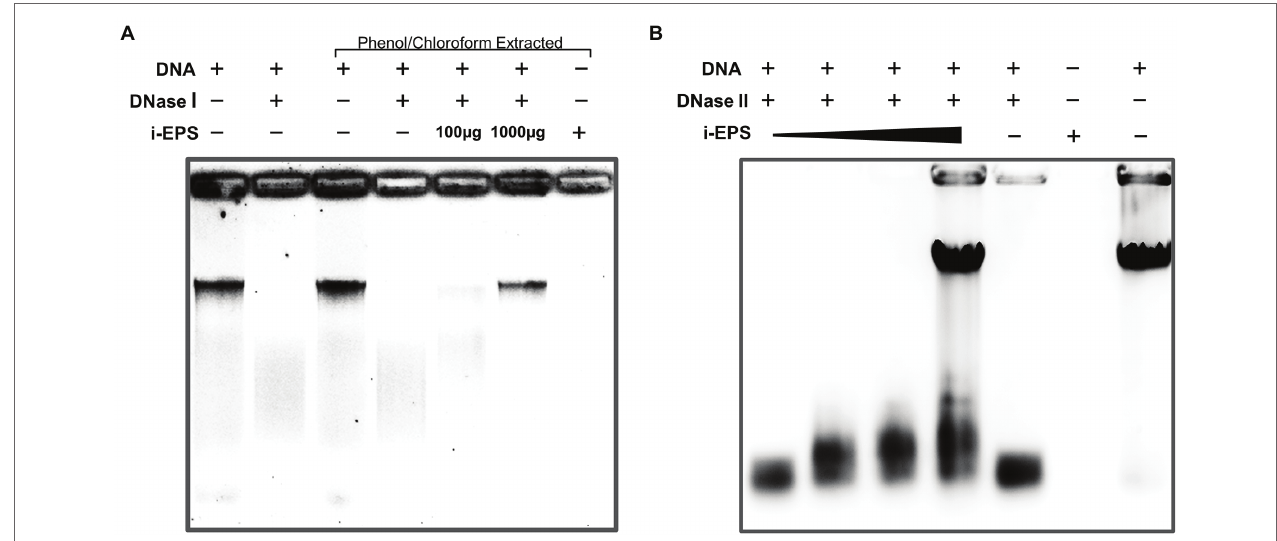
FIGURE 7 | Electrophoretic profile of digested DNA by DNase I (A) and DNase II (B) in the presence (+) and absence ( − ) of i-EPS. The DNA was electrophoresed on a 1.0% agarose gel. The gels were stained with EB and photographed under UV light with a gel documentation system. Images of stained DNA fragments were black/white inverted for a better